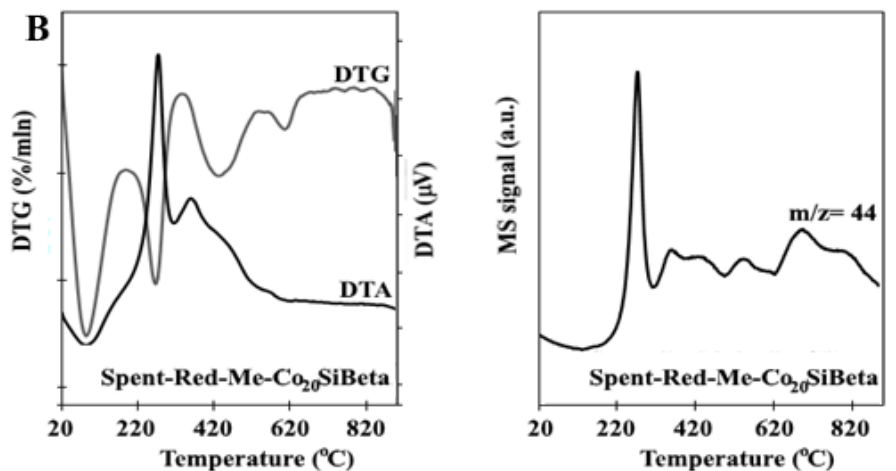
Figure 17. Investigation of carbon deposition on the ( A ) Spent-Red-Mi-Co 20 SiBeta and ( B ) Spent-Red-Me-Co 20